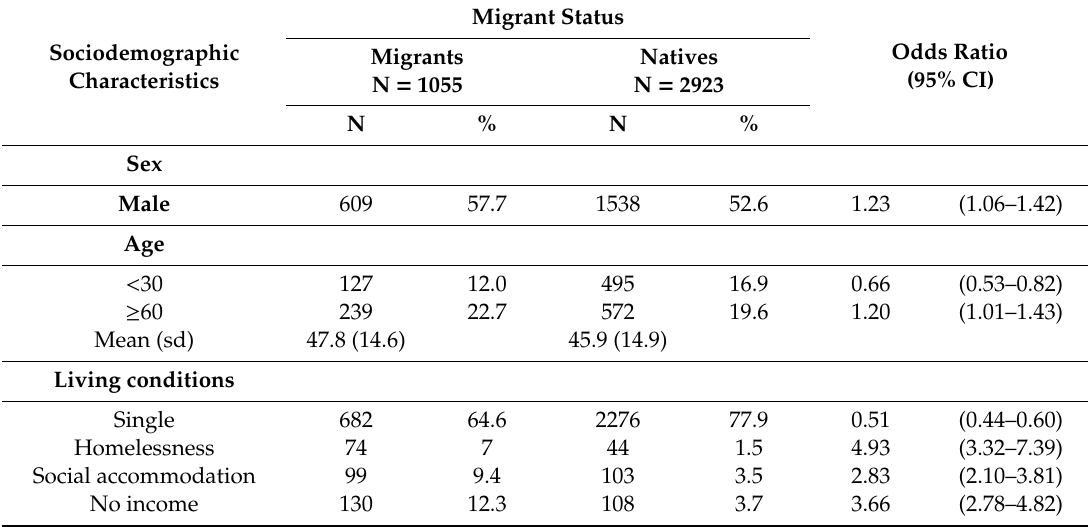
Table 1. Sociodemographic characteristics of the sample, by migrant